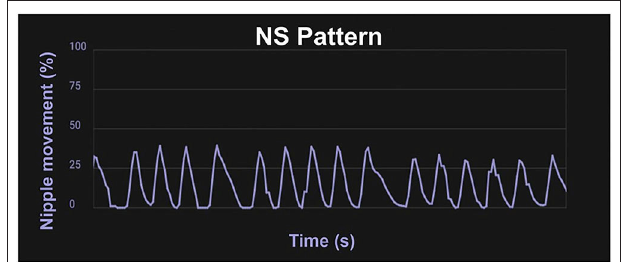
FIGURE 2 | Waveform pattern of NS. Graph from the infant Feeding Solution showing the extent of the movement of the lever inside the bottle nipple measuring the expression component of sucking with 100% being the furthest the lever inside the nipple can move, and 50% being half the maximum distance. A mature NS pattern demonstrates regular, smooth movement about one suck per second.